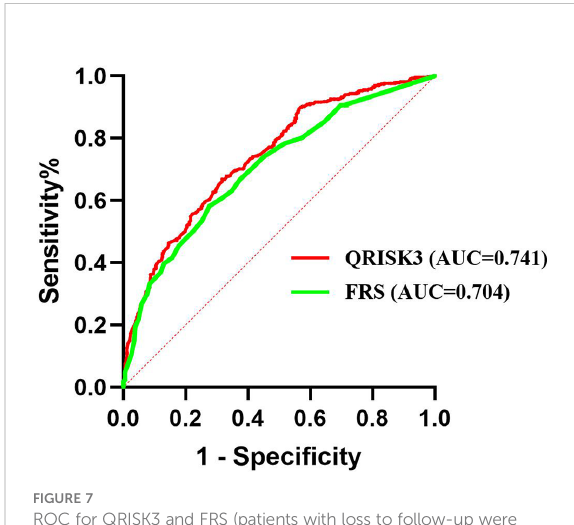
FIGURE 7 ROC for QRISK3 and FRS (patients with loss to follow-up were classi fi ed as CVD groups). Legend: All the patients who lost to follow-up were classi fi ed as CVD group. ROC, Receiver operating characteristics; AUC, area under the ROC curve; QRISK3, QRESEARCH Risk estimator version 3; FRS, Framingham risk score; CVD, cardiovascular